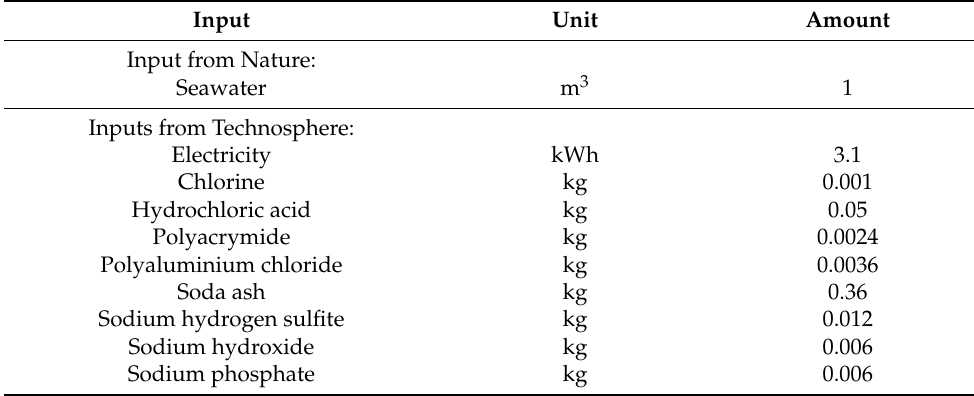
Table 1. Inventory of operational phase of SWRO